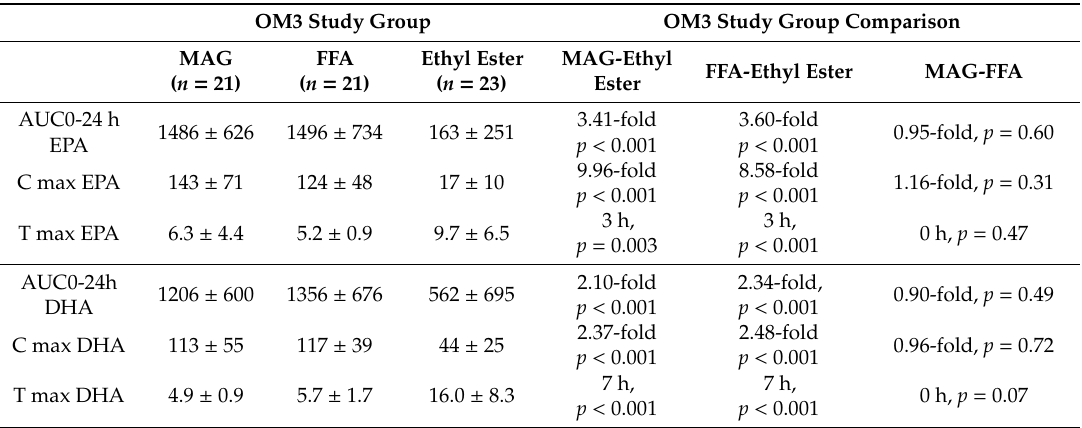
Table 4. Clinical Trial A: EPA and DHA summary statistics (mean and SD), baseline-adjusted, for AUC over 24 h postprandial.